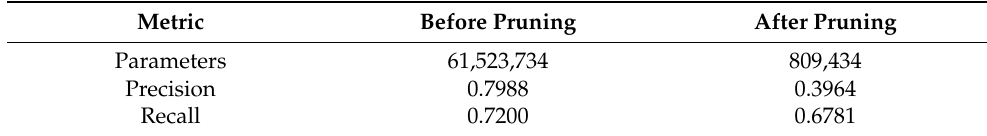
Table 2. Metrics before and after sparsity training.